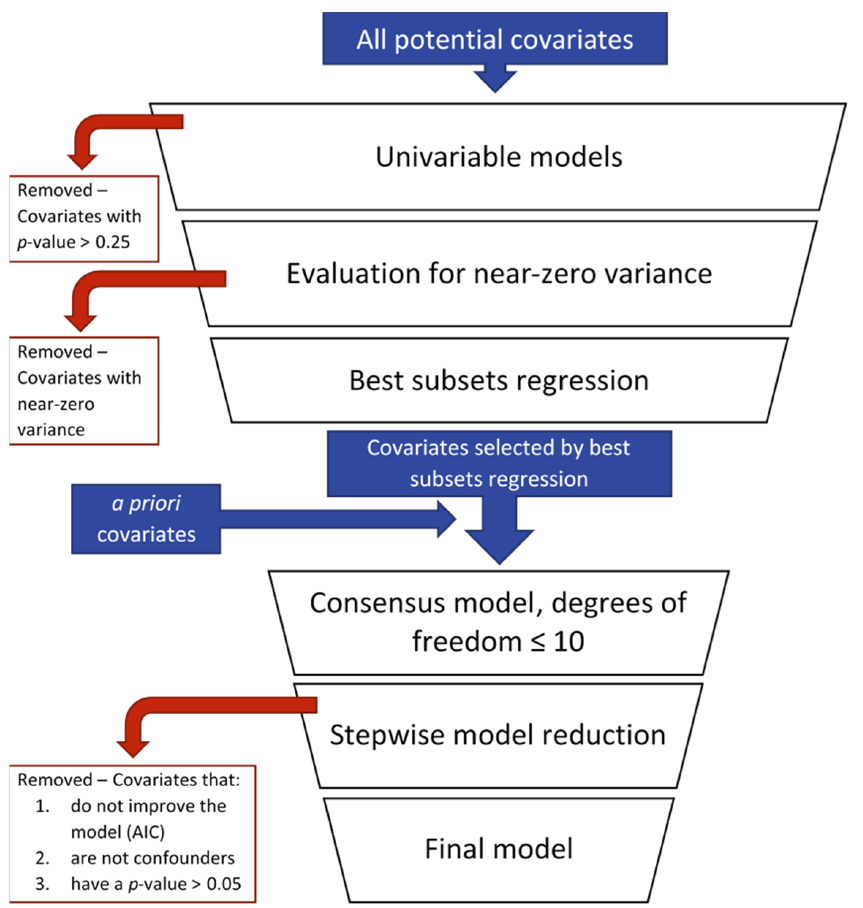
Figure 3. Flowchart of data-driven, best subsets regression approach for model building.